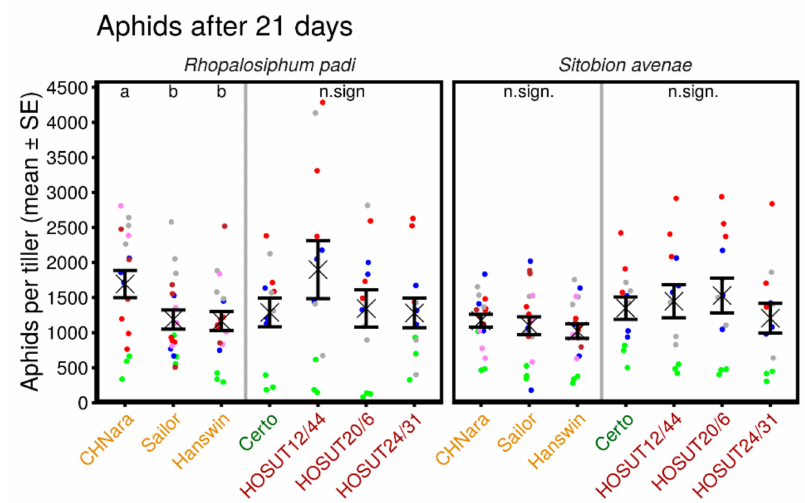
Figure 1. Population size of Rhopalosiphum padi (left panel) and Sitobion avenae (right panel) caged on one tiller of di ff erent winter wheat entries in the greenhouse. The population started with 15 newborn nymphs on each tiller, and all aphids in the cage were counted 21 days later. Statistical analyses were conducted for the conventional Swiss cultivars CH Nara, Sailor, and Hanswin. Separate analyses were conducted for the three HOSUT lines and the non-transformed parental cultivar Certo. Data were analyzed with linear mixed e ff ects models, fixed factor wheat entry, random factors repetition, duration and team member counting the aphids. N = 12 for Certo and HOSUT lines and N = 18 for Swiss cultivars. “n.sign.” indicates non-significant comparisons. Di ff erent letters indicate statistical di ff erences (Tukey HSD test). Dots represent data from individual replicates and jittering was applied for better visibility of otherwise overlaying dots. Colors represent experimental repetitions. Please note that the Certo / HOSUT treatments lack two repetitions (brown and purple). Black X-symbols indicate the mean with standard